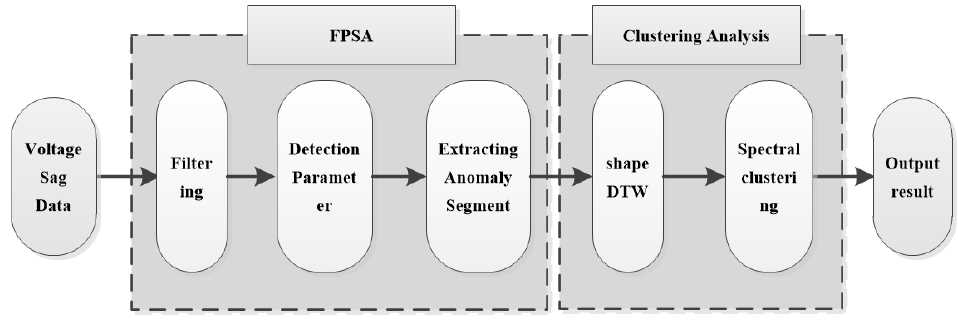
Figure 10. Procedure flow chart of the methodology.